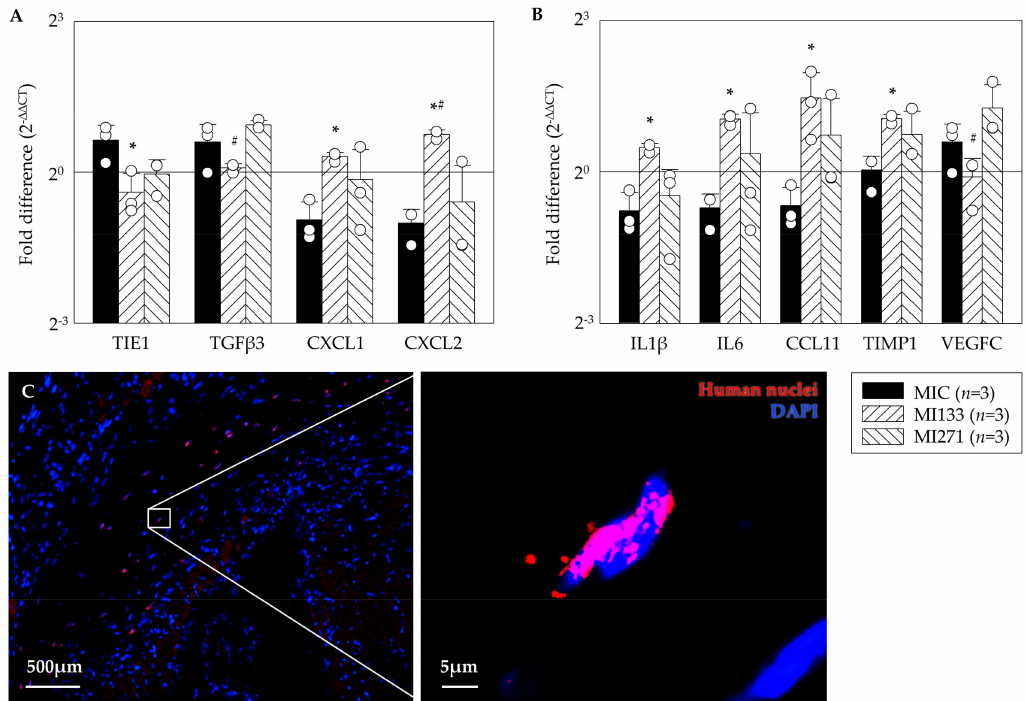
Figure 4. Angiogenic benefit 48 h after myocardial infarction (MI). Data show a significant lower expression of fibrotic markers as well as significant improvement of pro angiogenic factors after CD133 + cell treatment compared to MIC as well as MI271 group ( A ). Lower expression of inflammatory cytokines after CD271 + stem cell treatment in contrast to significantly increase after CD133 + stem cell treatment as well as significantly improvement of the pro angiogenic factor VEGFC (vascular endothelial growth factor) after CD271 + cell treatment. ( B ). Mean ± SD normalized to SHAM operation; * p ≤ 0.05 vs. MIC; # p ≤ 0.05 vs. MI271 ( t -test). Representative images of CD271 + cell derivatives illustrate the engrafted human stem cells 48 h post transplantation ( C